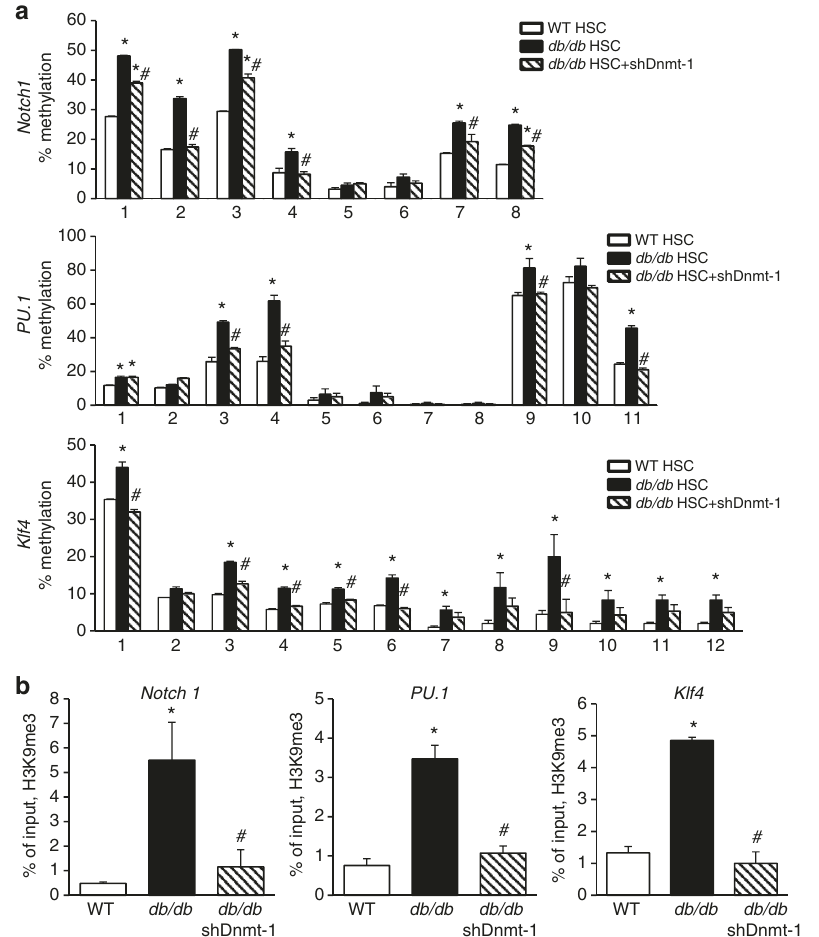
Fig. 8 T2DM upregulates Dnmt1 in db/db HSCs. a DNA methylation analysis by pyrosequencing ( n = 6, * p < 0.05 vs. WT; # p < 0.05 vs. db/db ). b ChIP-PCR analysis of histone modi fi cations ( n = 6. * p < 0.05 vs. WT; # p < 0.05 vs. db/db ). Results are expressed as means ± SEM. One way ANOVA was used for a ,